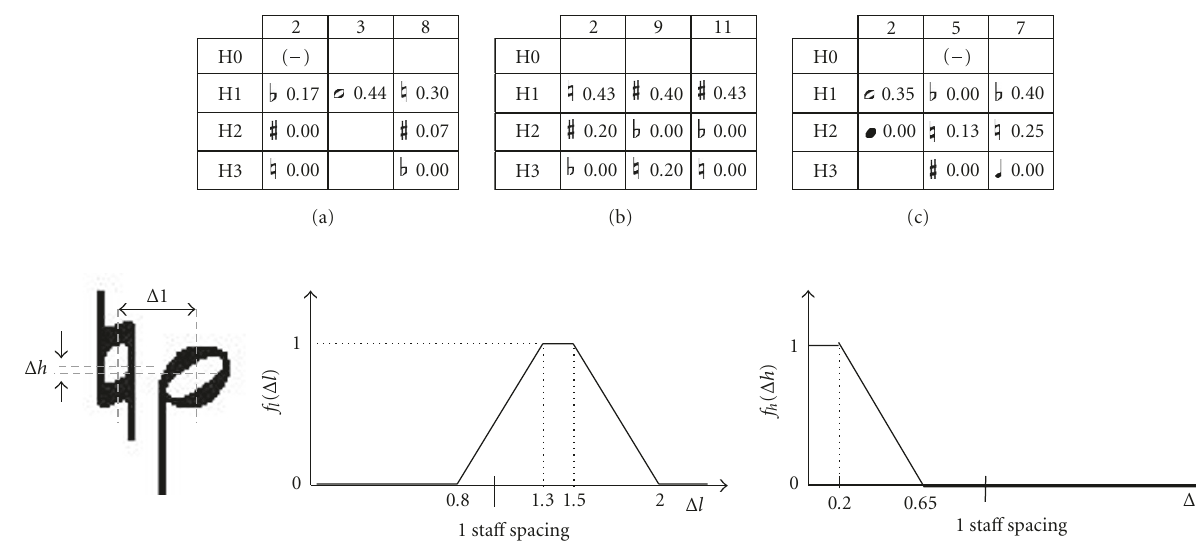
Table 2: Some hypotheses and possibility degrees.